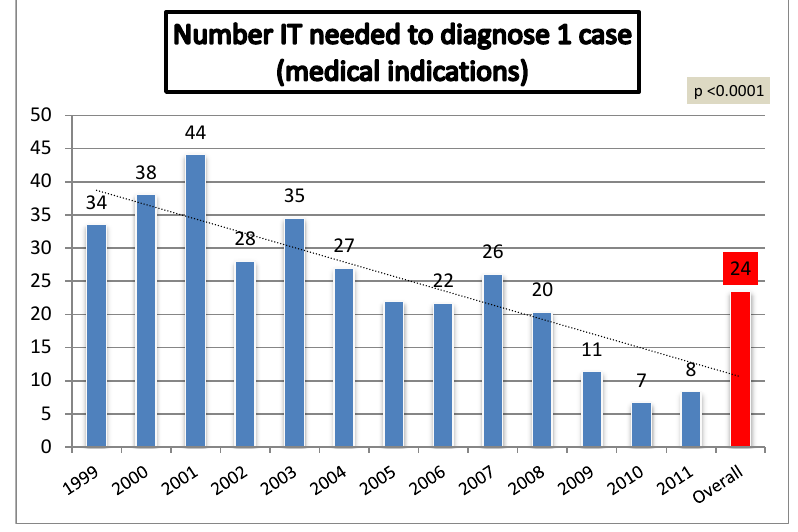
Figure 10. Number of invasive tests needed to diagnose one case of relevant chromosomal abnormality in population referred by medical